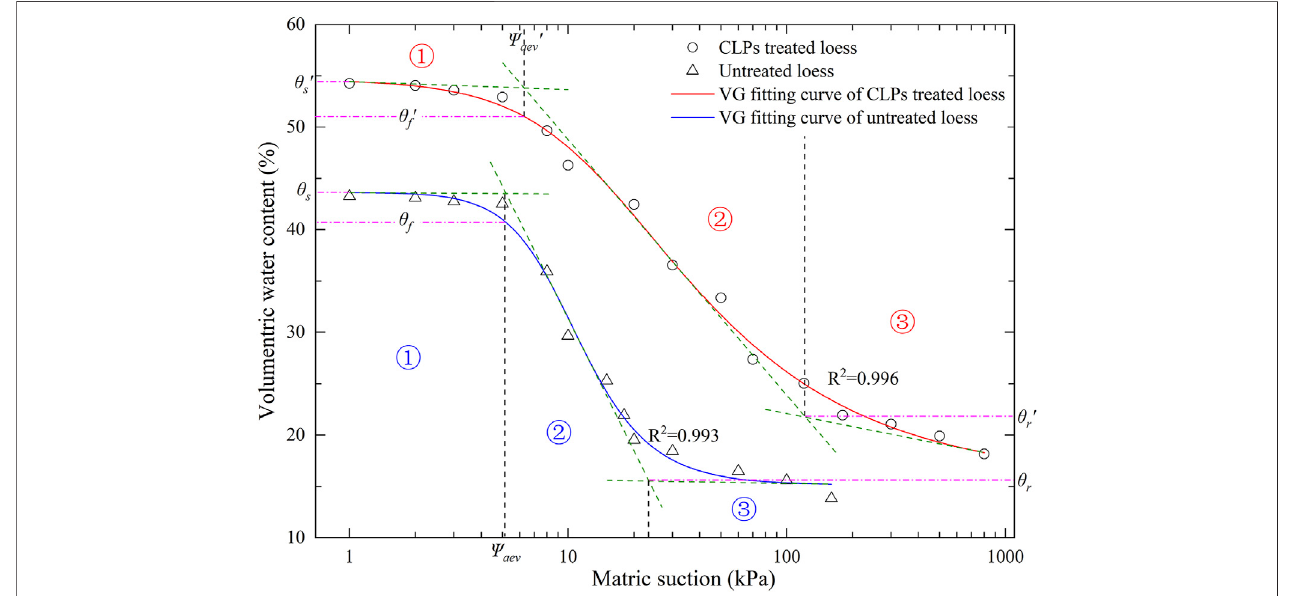
FIGURE 7 | Soil-water characteristic curve of treated and untreated loess. Regions ① , ② , and ③ represent the boundary (gravity water loss area), transition (capillary water loss area), and residual (combined water loss area) stages, respectively (White et al., 1970; Vanapalli et al., 1999).